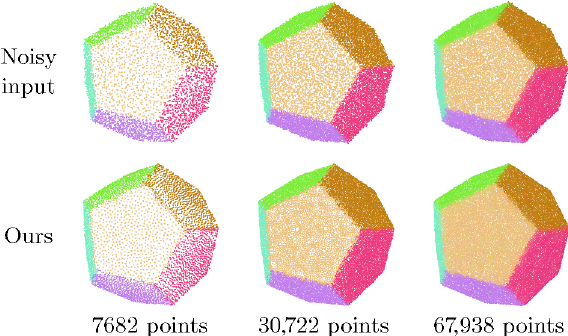
Fig. 17 Filtered results for models with different numbers of sample points.